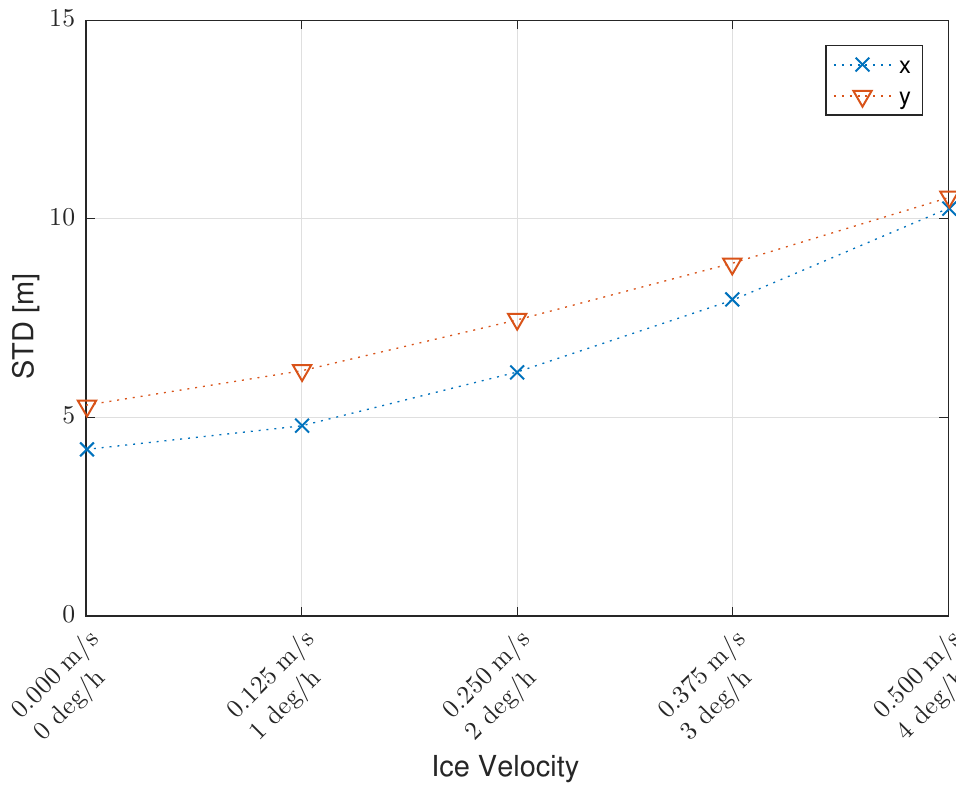
Figure 6. Ice-relative vehicle x − y position uncertainty averaged over each simulated mission, for five different linear and angular ice velocities. A 500 m GNSS line configuration and 40 m OWTT beacon spacing are used for each